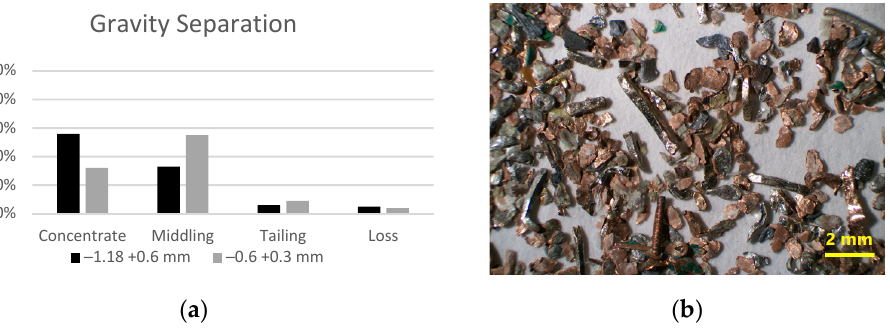
Figure 4. Weight of the products from shaking table as percentage ( a ); The concentrate product for the particle size class − 0.6 + 0.3 mm ( b ).